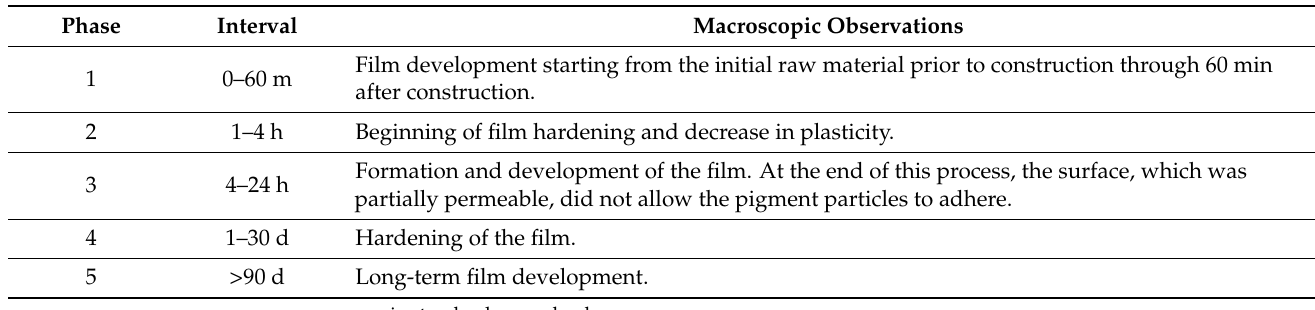
Table 2. Evolution over time of the surface of a slaked lime putty